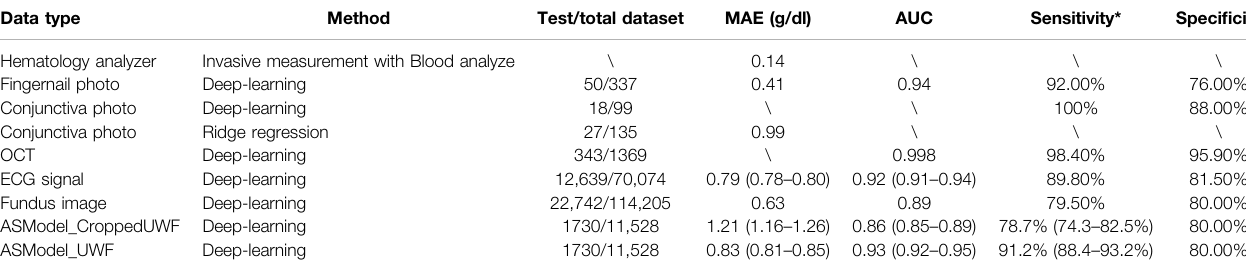
TABLE 1 | Performance comparison for different methods of hemoglobin prediction and anemia screening. Data type